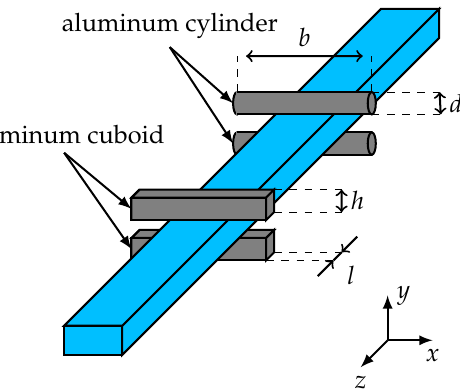
Figure 6. Positioning of the different targets at the dielectric waveguide.